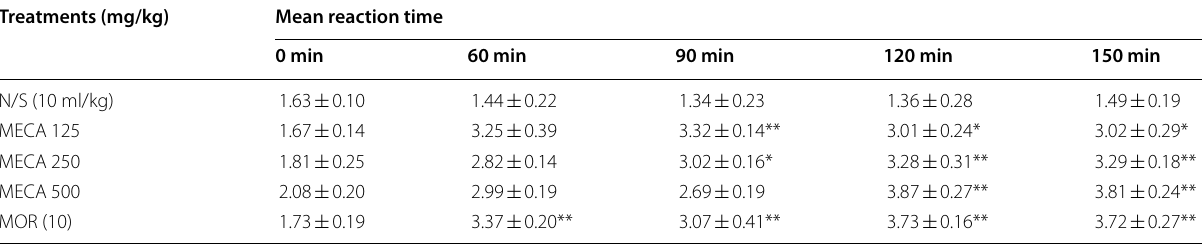
The values were analysed by repeated-measures ANOVA followed by Bonferroni post hoc test and presented as mean N/S, normal saline; MECA, methanol leaf extract of Culcasia angolensis ; MOR, morphine * p 0.05, ** p 0.01 significant statistical increase in mean reaction time compared with time zero; n ≤ ≤